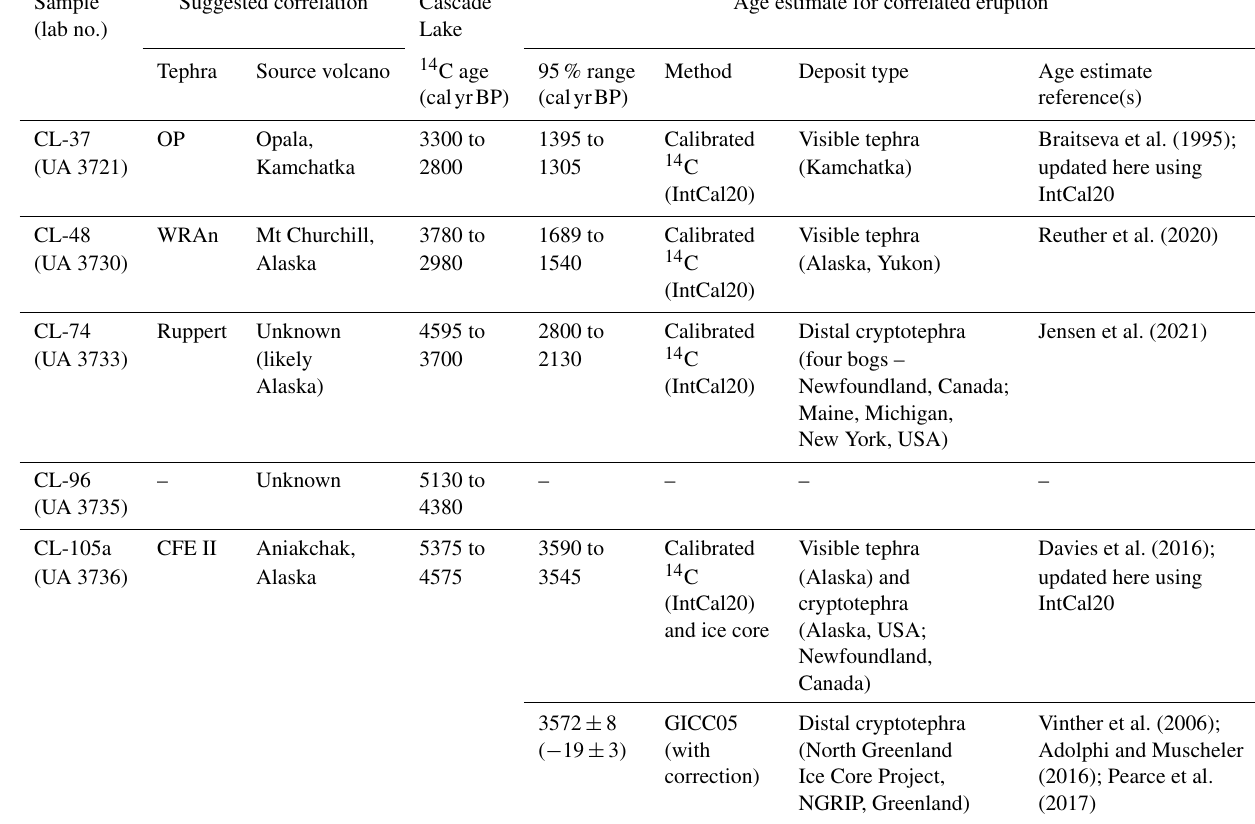
Table 3. Cascade Lake cryptotephra and its suggested correlative eruptions. Radiocarbon modelled age estimates produced in this paper for the core depth of the cryptotephra are compared with published ages for the listed eruptions. Bayesian modelled ages for both Aniakchak CFE II and Opala are updated here using OxCal v4.4 (Bronk Ramsey, 2009a) and IntCal20 (Reimer et al.,